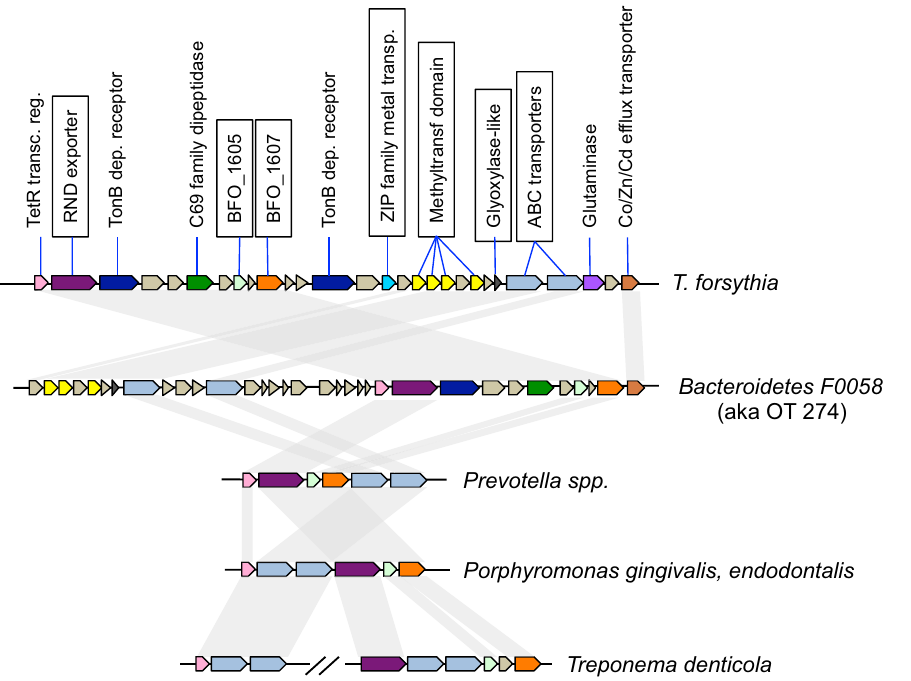
Figure 4. Genome maps of a gene cluster in T.forsythia and other organisms. The cluster was identified by a bioinformatics screen for possible virulence genes, identifying genes with homologs in T. forsythia and at least one of six Bacteroidetes organisms associated with chronic periodontitis, but absent from the five longest BU063 assemblies (protein BLAST results with cut-offs 30% identity and e-value 10 2 5 ). A cluster of genes including many with apparent cell-surface function was identified within the results. The predicted gene functions are shown above the T. forsythia map, with colors indicating conserved genes in the other organisms. The boxed genes are more similar to the other periodontitis-associated organisms than to BU063 . Gray bars in the background show the pattern of sequence conservation by connecting genes to homologous genes in the other organisms. doi:10.1371/journal.pone.0089398.g004 PLOS ONE |